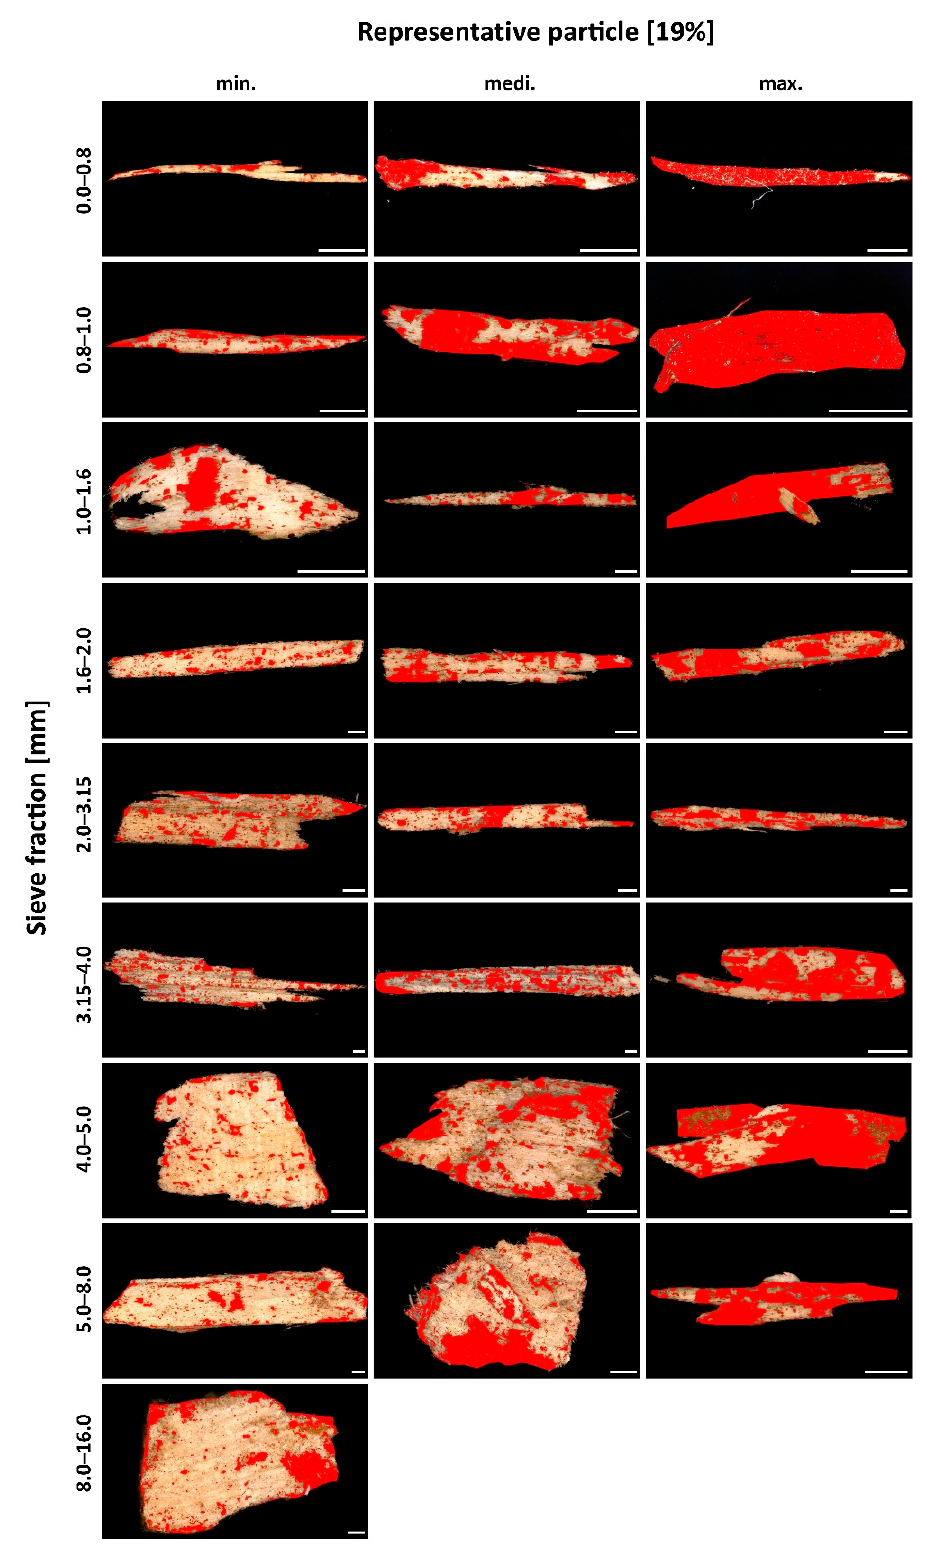
Figure 10. Particle Material 3 (AC 19%). For each of the first eight sieve fractions, a particle with the lowest degree of surface coverage, an intermediate degree of surface coverage, and the highest degree of surface coverage. For the largest sieve fraction, only one particle was available for evaluation. Scale 1000 μ m.